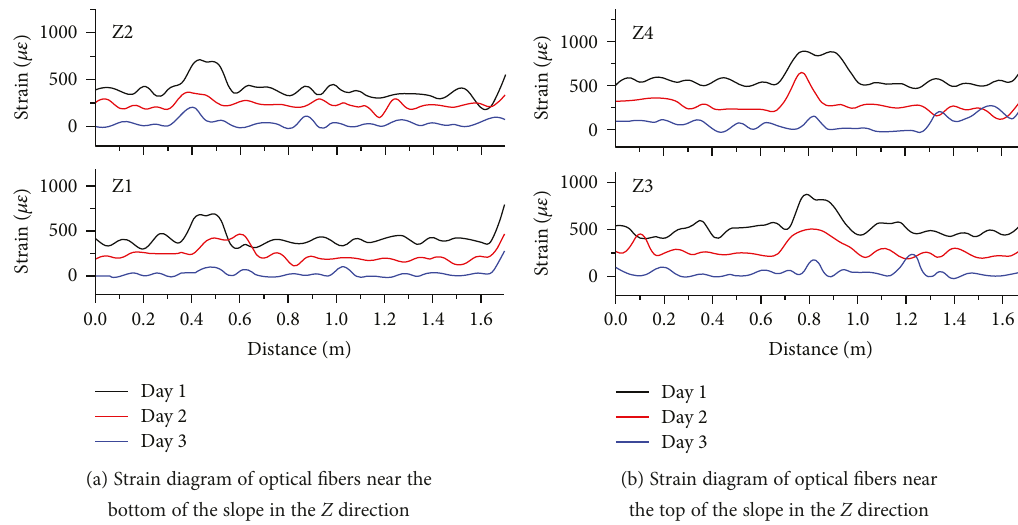
Figure 14: Comprehensive strain diagram of optical fi bers in the Z direction with three days of rainfall.